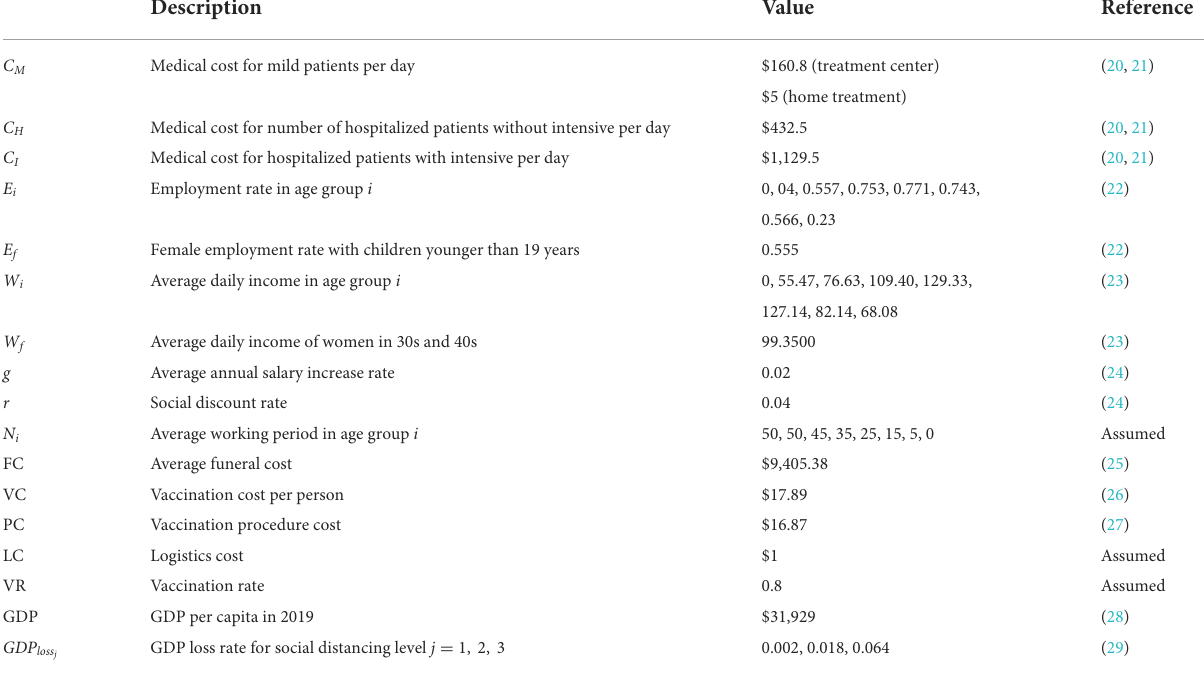
TABLE 3 Descriptions and values of parameters for cost estimation.